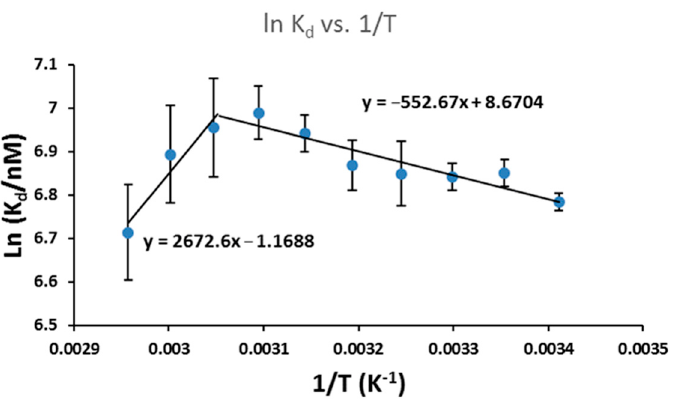
Figure 6. Van ’t Hoff plot for dissociation equilibrium of sisomicin-RNA repeats at 20–65 ◦ C. Annealed FM1 r(CUG) 10 RNA sample concentration 200 nM and volume size 150 µ L; sisomicin addition volume size 1.5 µ L with ligand to RNA molar ratios of 0, 1, 4, 8, and 16; fluorescence setting: excitation at 485 nm, emission at 500–600 nm, and slit width of 3 nm.